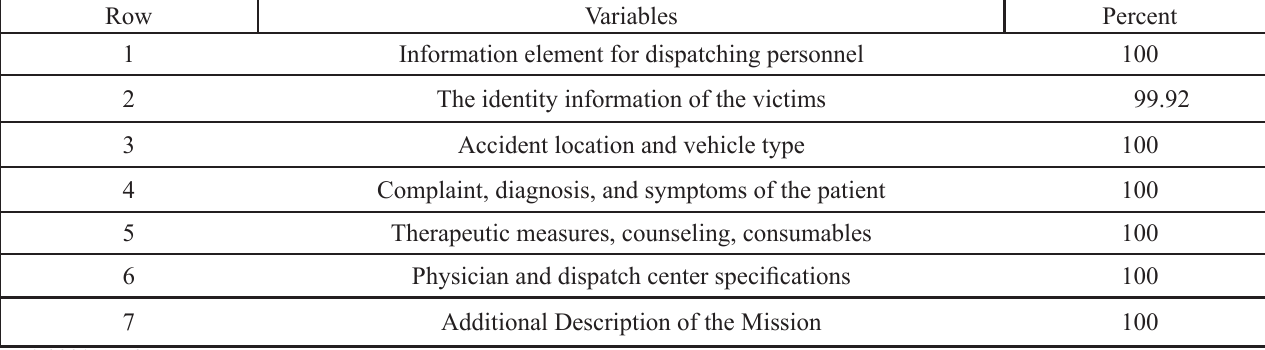
Table 2. Accuracy rate of the EMS 115 Care Report form traffic injured in Mashhad Social Welfare Hospitals, 2018